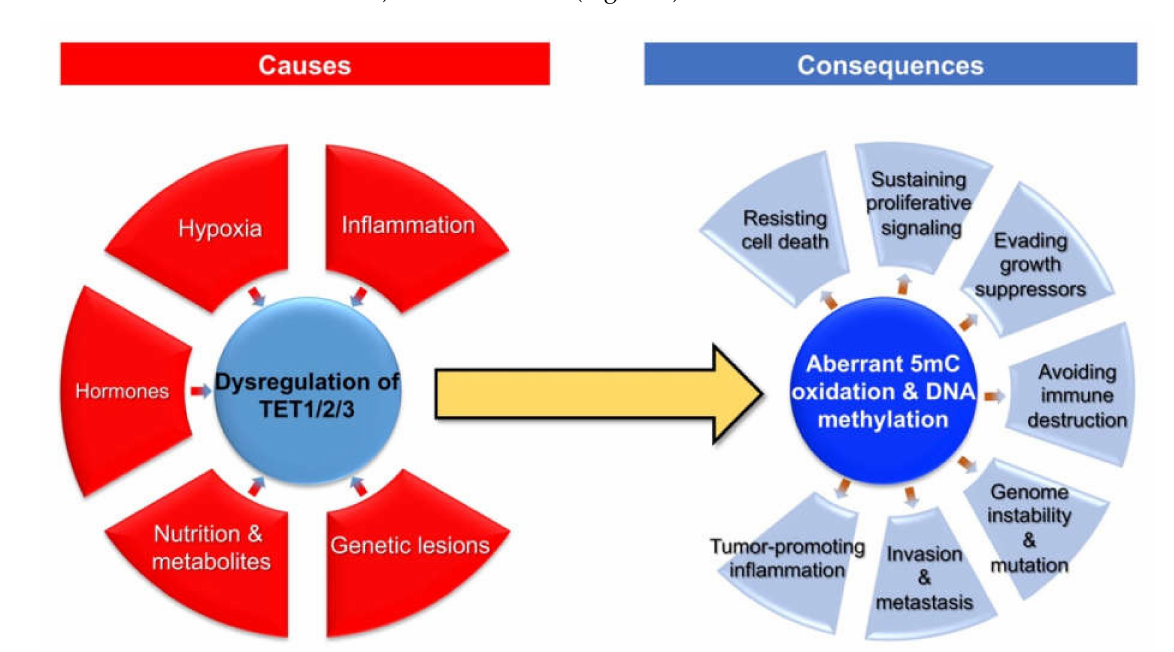
Figure 2. Causes and consequences of aberrant 5mC oxidation in breast